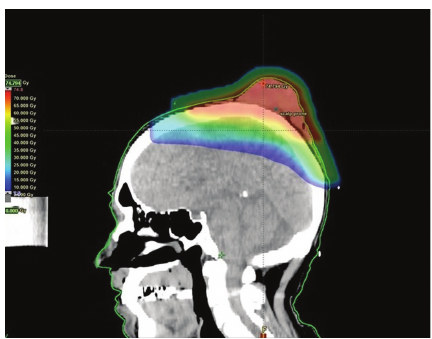
Figure 3: Dosimetry of VMAT plan for the patient of Case 1. After a rest period of fourteen days, further 40Gy/20 fractions of radiotherapy were administered to allow further tumour shrinkage prior to resection.